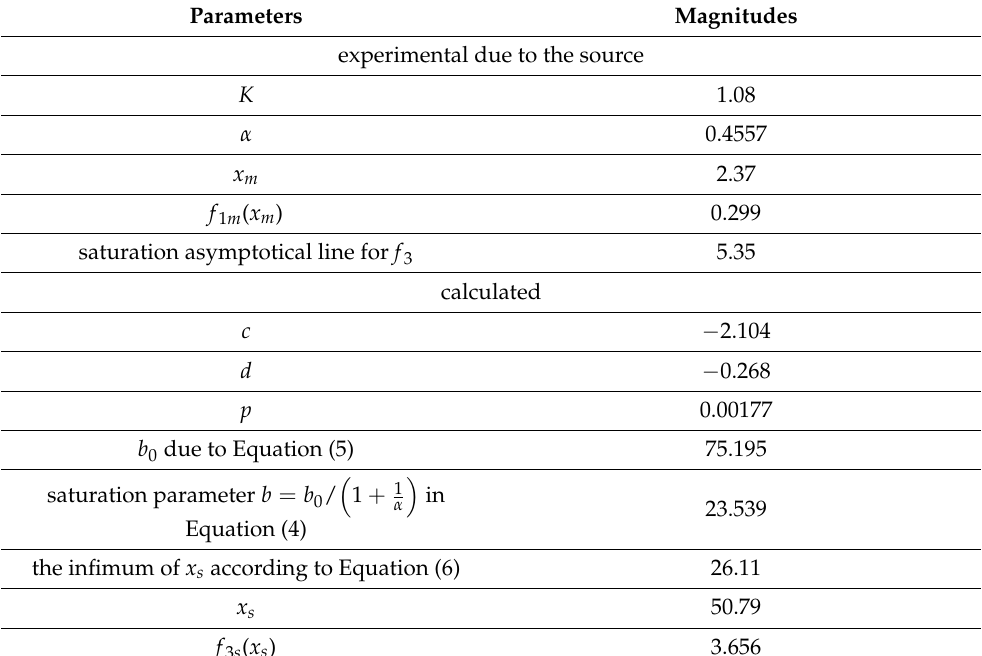
Table 1. Linkage parameters for the system with adsorption of phosphates on recycled brick waste [2] (Figure